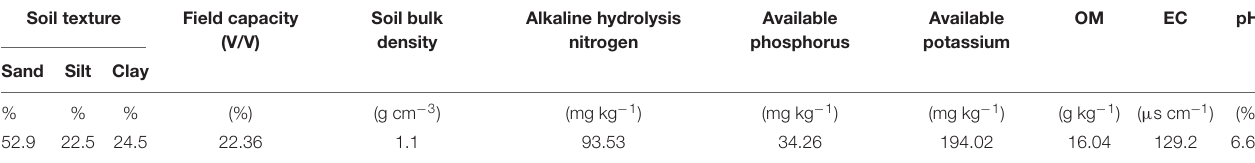
TABLE 1 | Soil basic physical and chemical properties. Soil